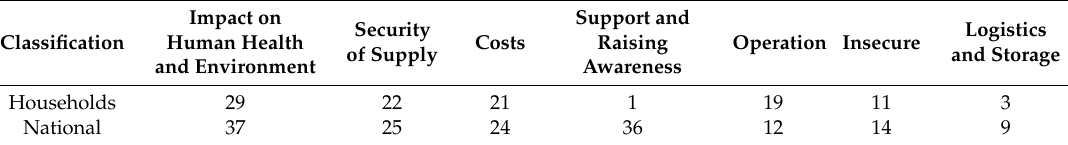
Table4. Thematicclassificationofthenotionsandaspectsmentionedduringthefocusgroupdiscussions.